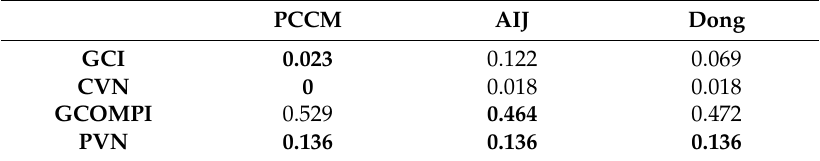
Table 5. Consistency and compatibility indicator values (the best value of the methods is in bold, for each